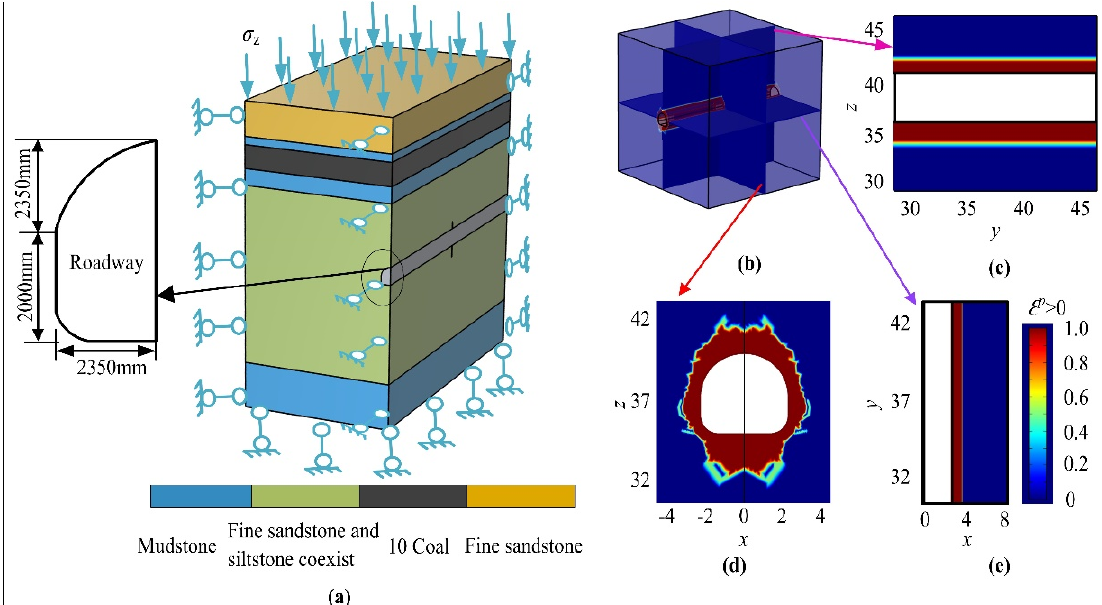
Figure 11. Numerical model and plastic failure characteristics of the three-level main roadway. ( a )